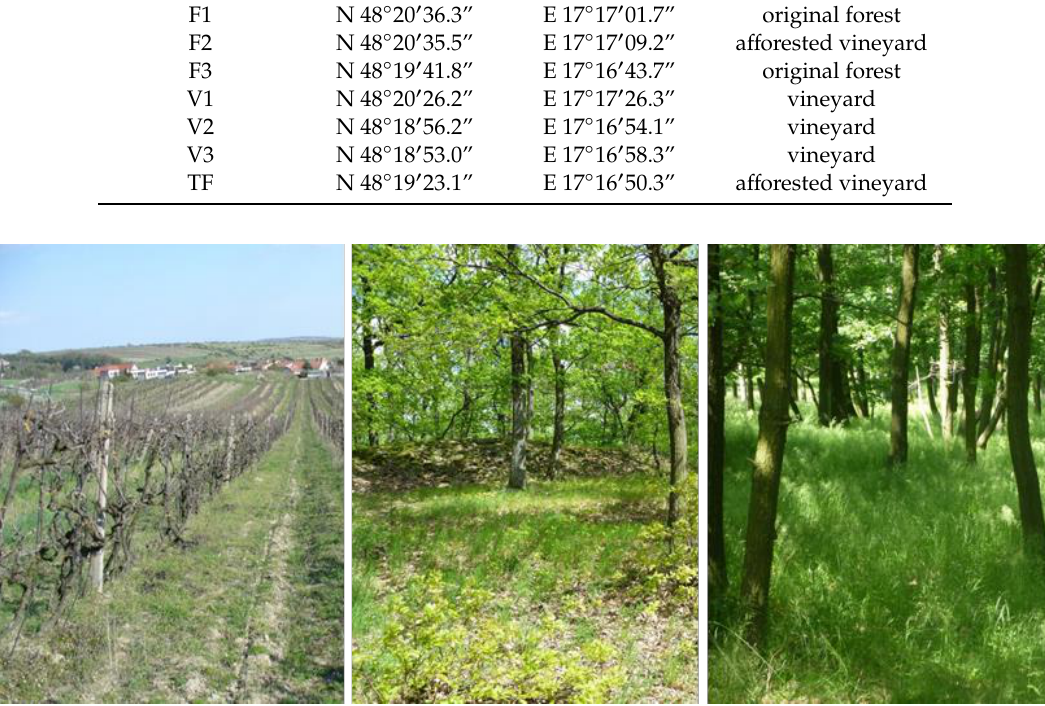
Figure 1. Left to right: the vineyard, afforested, and forest plots.